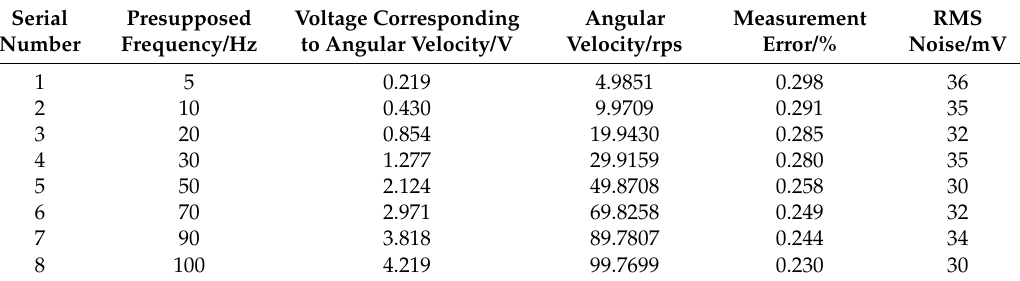
Table 3. Measurement results of angular velocity parameter.